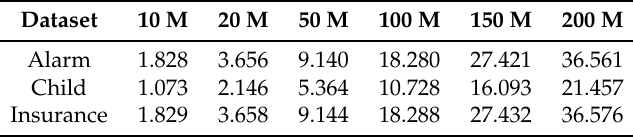
Table 2. Data set sizes (unit: GB).